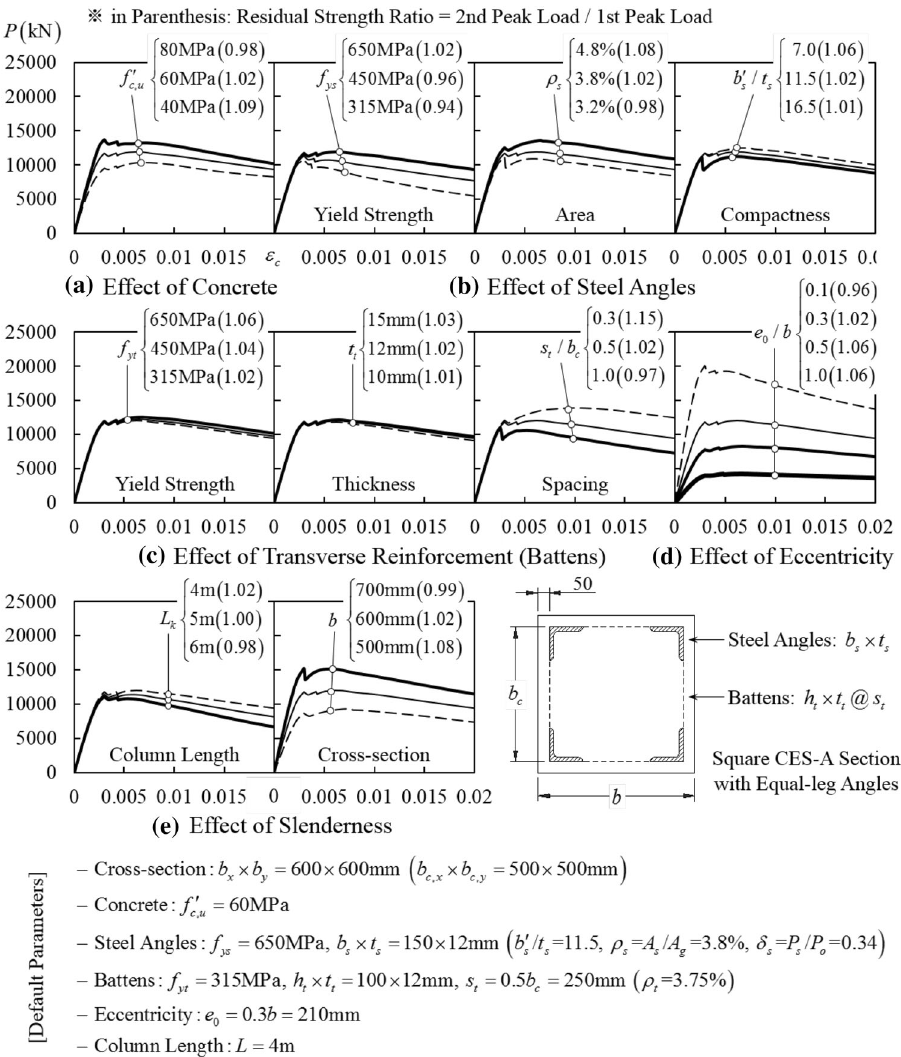
Fig. 10 Parametric study results (evaluated at mid-height